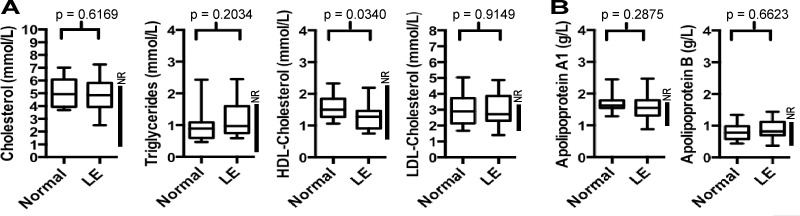
Total Serum Lipids and Lipid Transport Molecules.(A) Box and whisker plots of total serum cholesterol, triglycerides, HDL-cholesterol and calculated LDL-cholesterol, and (B) Total serum lipoprotein apoprotein A1 and apolipoprotein B, from LE patient (n = 15) and normal cohort (n = 11) peripheral blood samples. The line within each box indicates the global median value calculated from the cohort. The generally accepted population normal range (NR) is shown within each graph (vertical line, right hand side). Statistical significance (p value) between LE and Normal (non-LE) are also shown, as determined by two-tailed t-test, not assuming equal variance.